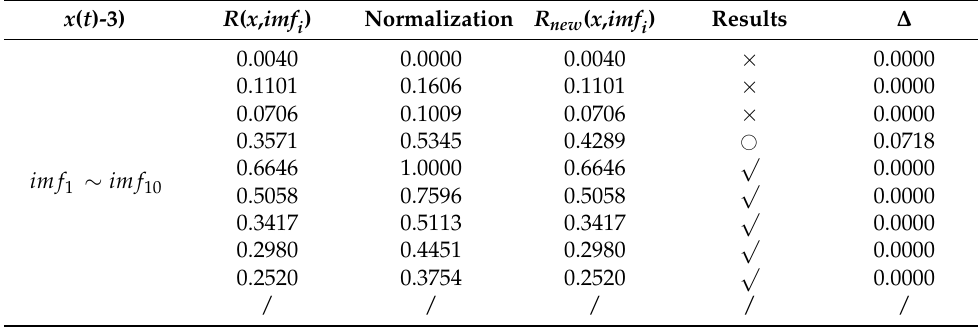
Table 4. Correlation coefficient of IMFs ( x ( t